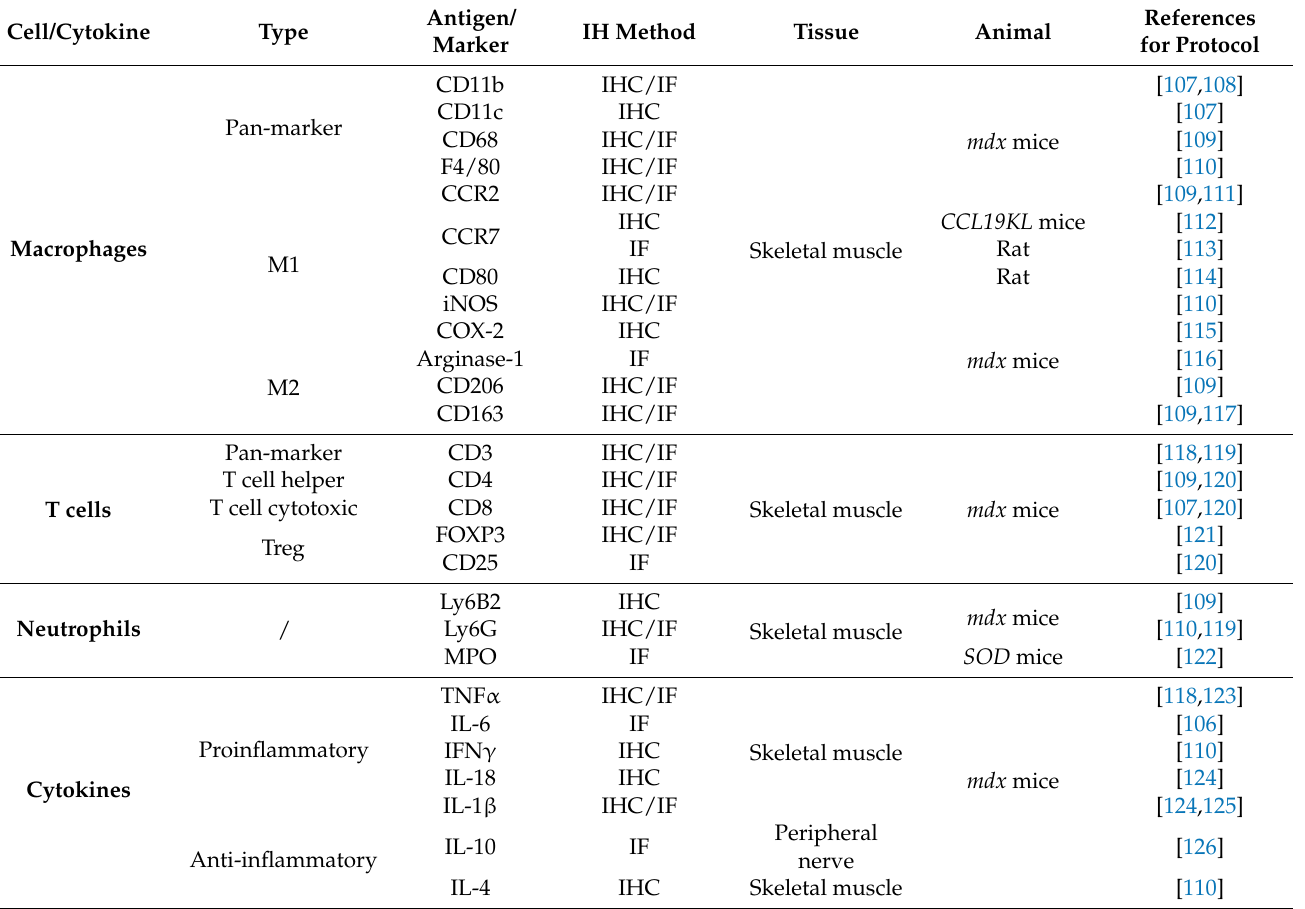
Table 2. Markers of the inflammatory process in rodent